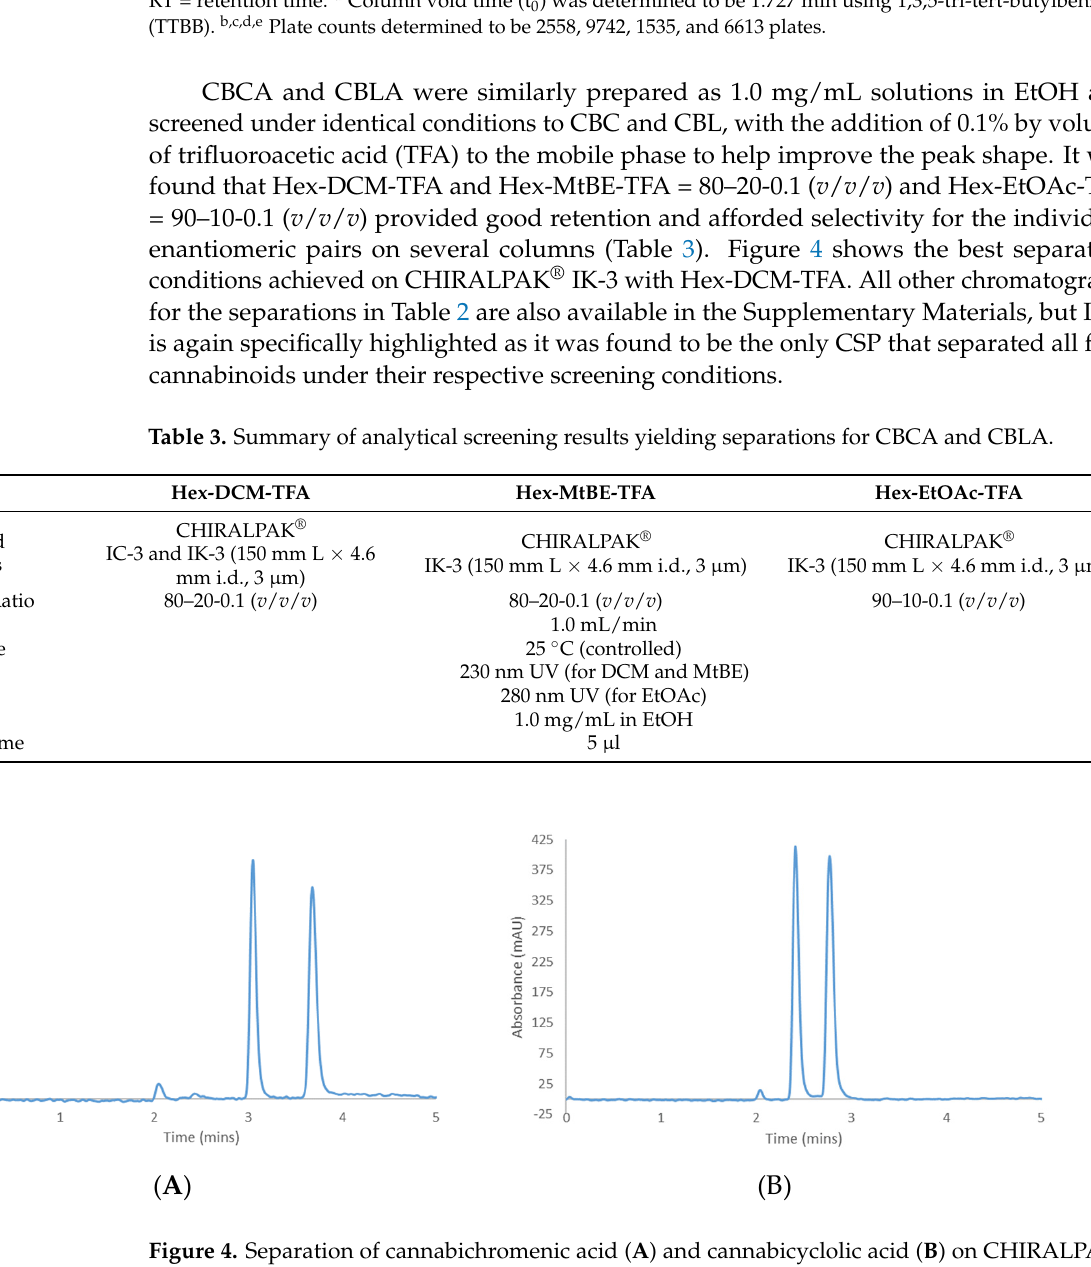
Table 3. Summary of analytical screening results yielding separations for CBCA and CBLA .